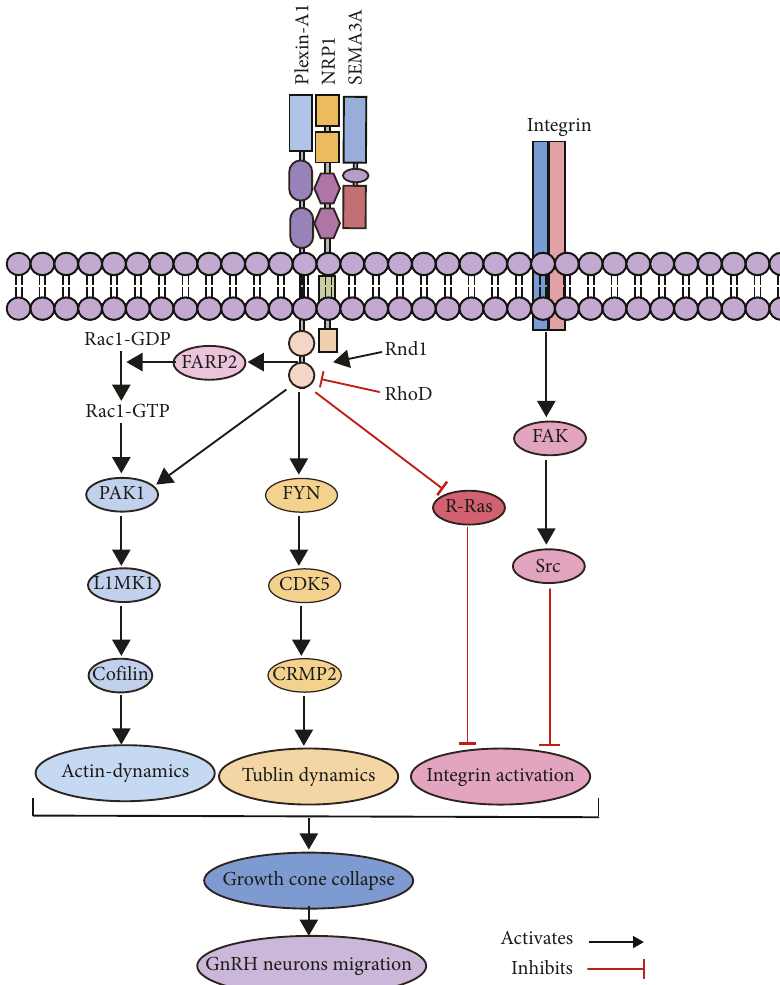
Figure 4: Mechanism of SEMA3A signaling. The formation of the SEMA3A-NRP-Plexin complex induces the release of FARP2, which can exchange the small G-protein Rac1-GDP to Rac1-GTP. Then, it sequentially activates p21-activated kinase (PAK), LIM kinase 1 (LIMK1), and the actin-binding factor Cofilin, which finally induces actin dynamics and subsequently shifts the balance of Rnd1 and RhoD activity towards this function. Once activated, Plexin can in turn trigger cytoplasmic tyrosine kinases FYN and the serine/threonine kinase CDK5, as well as the collapsin response mediator protein CRMP2, thereby resulting in tubulin dynamics. Activation of plexin-A1 also leads to inactivation of R-RAS, which regulates the function of integrin, resulting in the inactivation of integrin, thereby promoting the separation of target cells and extracellular matrix. SEMA3A can also cause the phosphorylation and dephosphorylation of FAK, thereby activating the downstream Src kinase to achieve the inhibitory effect on integrins. The four pathways mentioned above can eventually cause the growth cone to collapse and ultimately affect the migration of neuronal